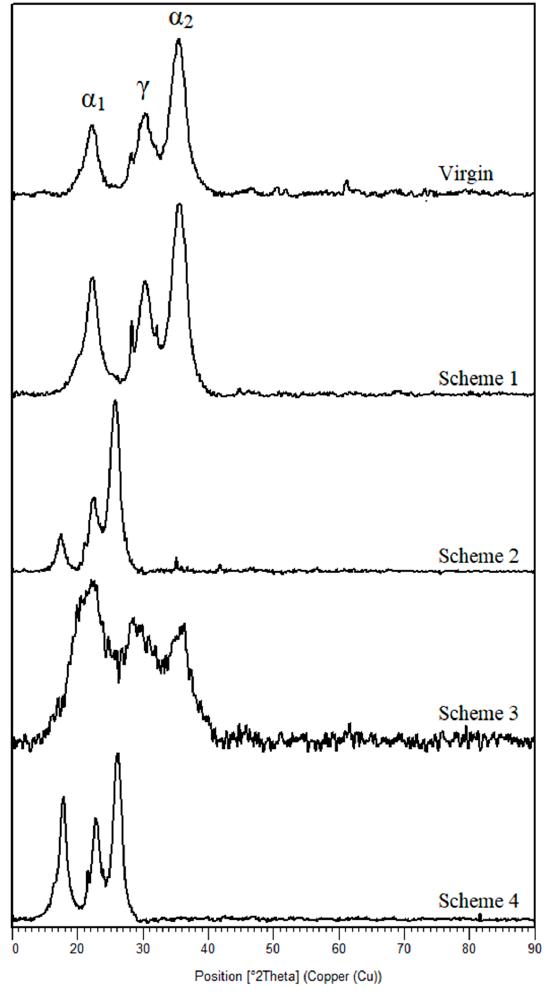
Figure 7. The XRD spectra of virgin and fouled membranes.